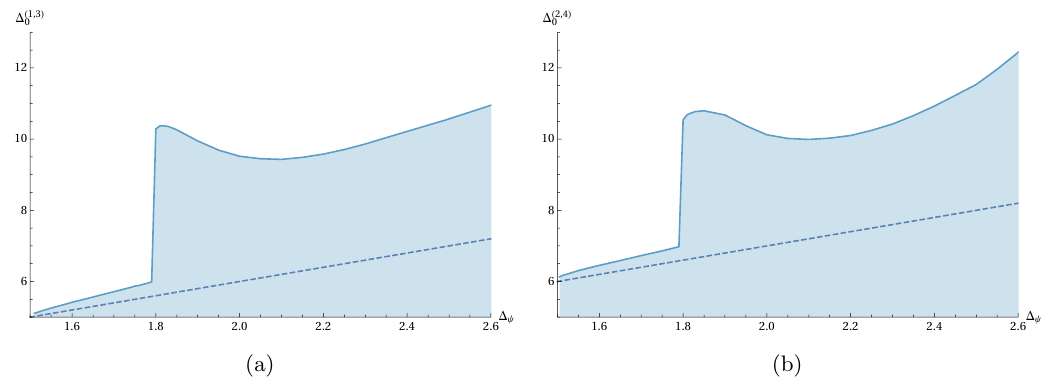
Figure 18 . Left: upper bound on the dimension of the (cid:12)rst (1 ; 3) neutral NTS operator. Right: upper bound on the (cid:12)rst (2 ; 4) neutral NTS operator. The shaded region is the allowed one. The bounds have been computed at (cid:3) = 16. The dashed lines represent the